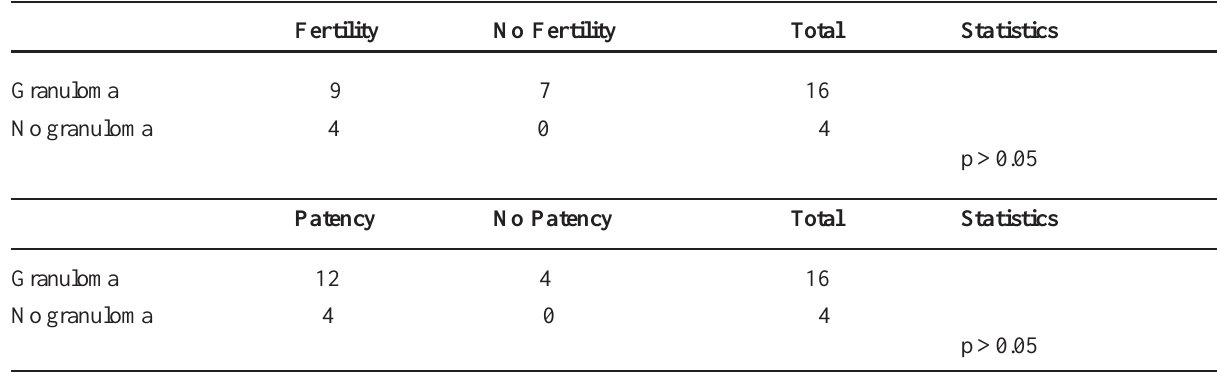
Table 2 – Comparison between spermatic granuloma in vasovasostomy site and patency rates in vasovasostomy with fibrin glue.